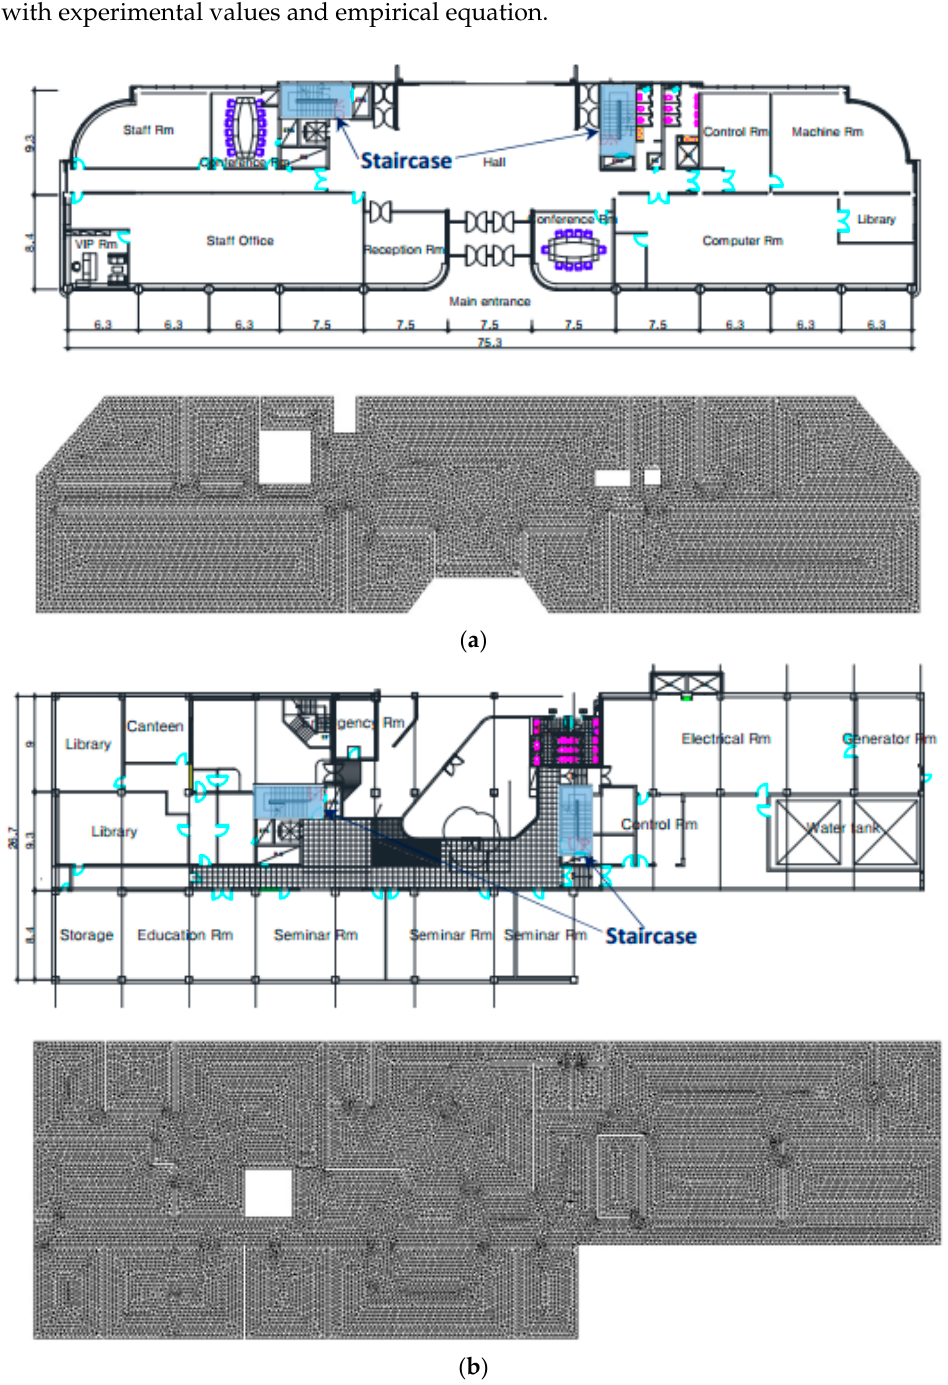
Figure 5. Application site containing two layers: ( a ) ground floor (above: architectural design plan; below: mesh layout); ( b ) underground space (above: architectural design plan; below: mesh layout).